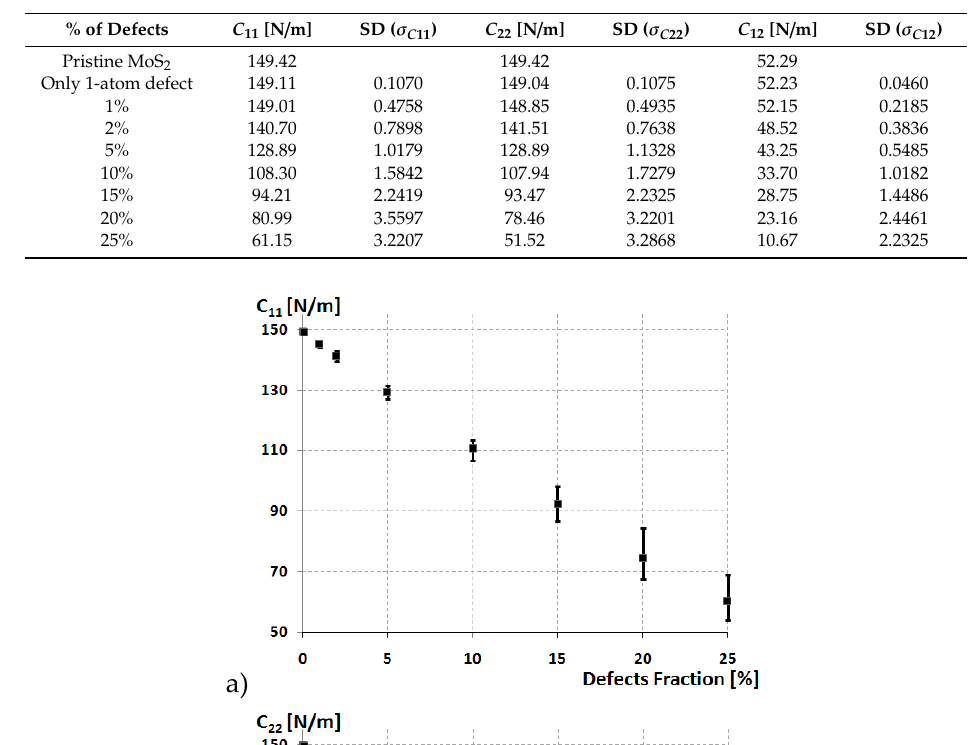
Table 2. The mechanical parameters for MoS 2 for di ff erent defect fractions along with Standard